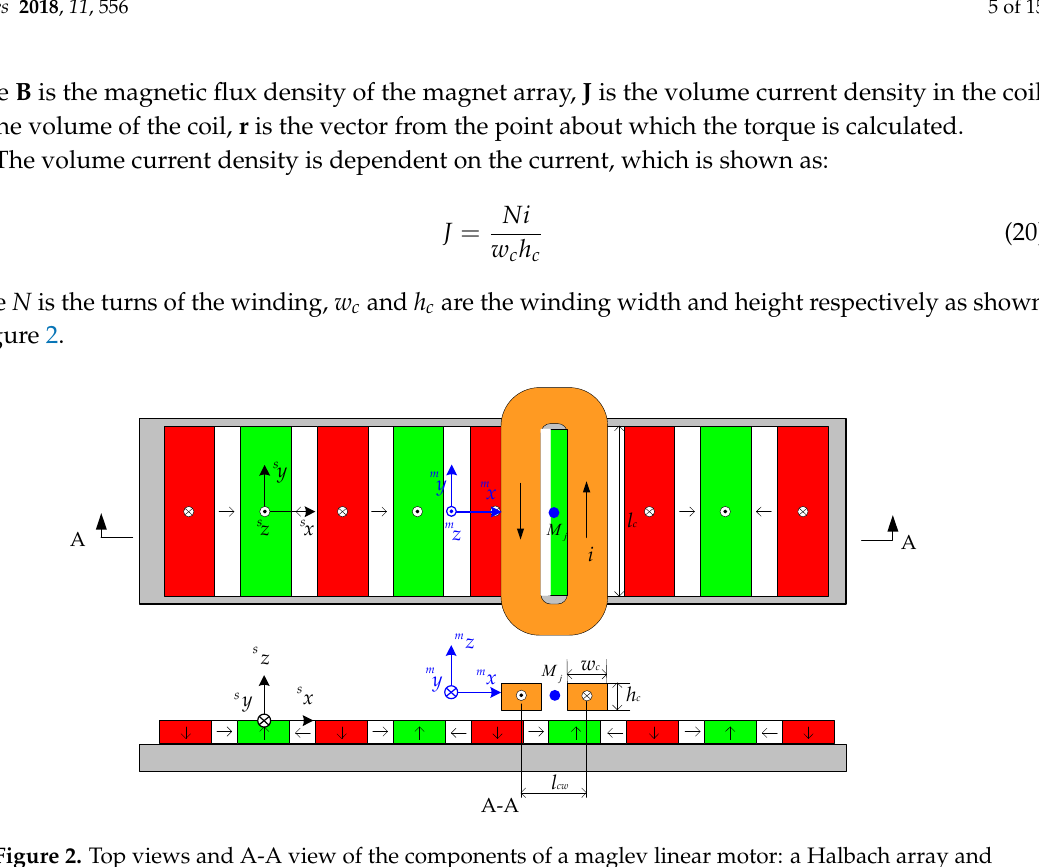
Figure 2. Top views and A-A view of the components of a maglev linear motor: a Halbach array and a coil. Point M j is the position in the local coordinate system.